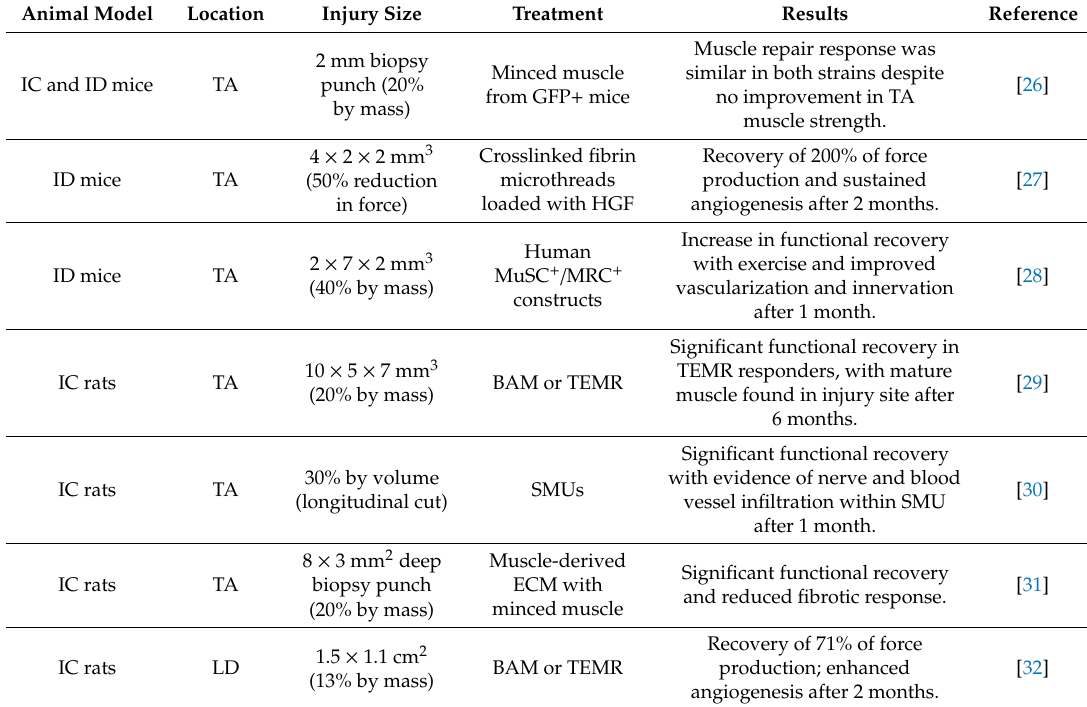
Table 3. Selection of recent volumetric muscle loss (VML) studies to study the skeletal muscle repair. Animal